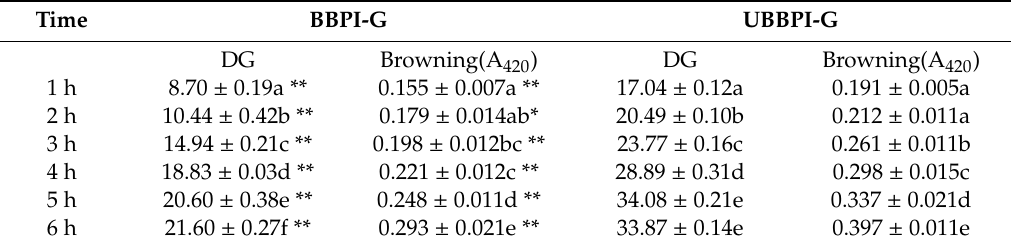
Table 1. DG and browning values of BBPI-G conjugates and UBBPI-G conjugates. Time BBPI-G UBBPI-G DG Browning(A 420 ) DG Browning(A 420